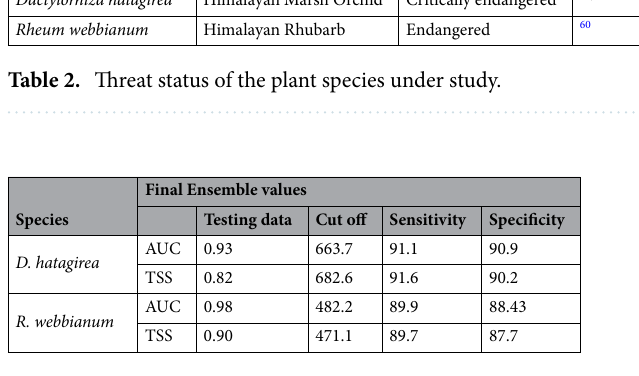
Table 3. Final AUC (ROC) values of Dactylorhiza hatagirea and Rheum webbianum.